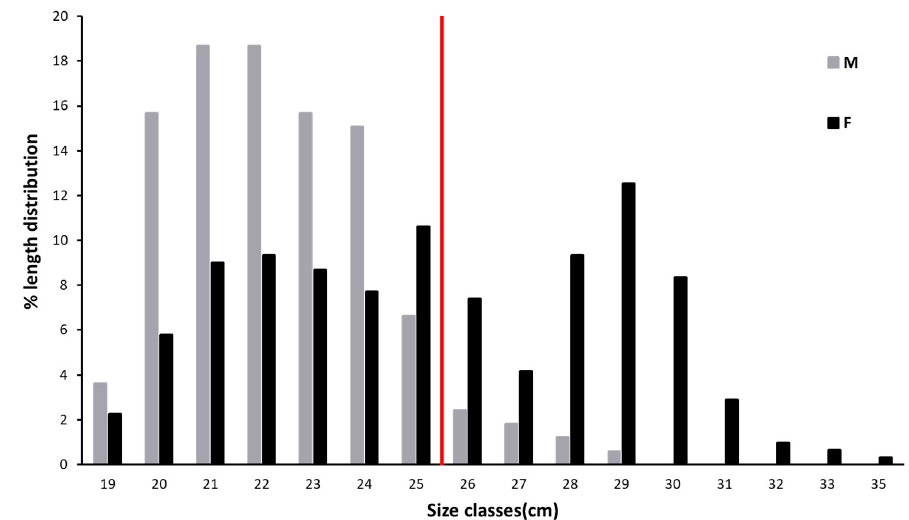
Figure 2. Length frequency distribution of n = 477 specimens of Solea solea collected from January to December 2019 in the Central Adriatic Sea for a study of their diet (the red bar separates specimens assigned to medium size 1, hereafter medium size (M) to those of size 2, hereafter large size (L) (threshold = 26 cm).